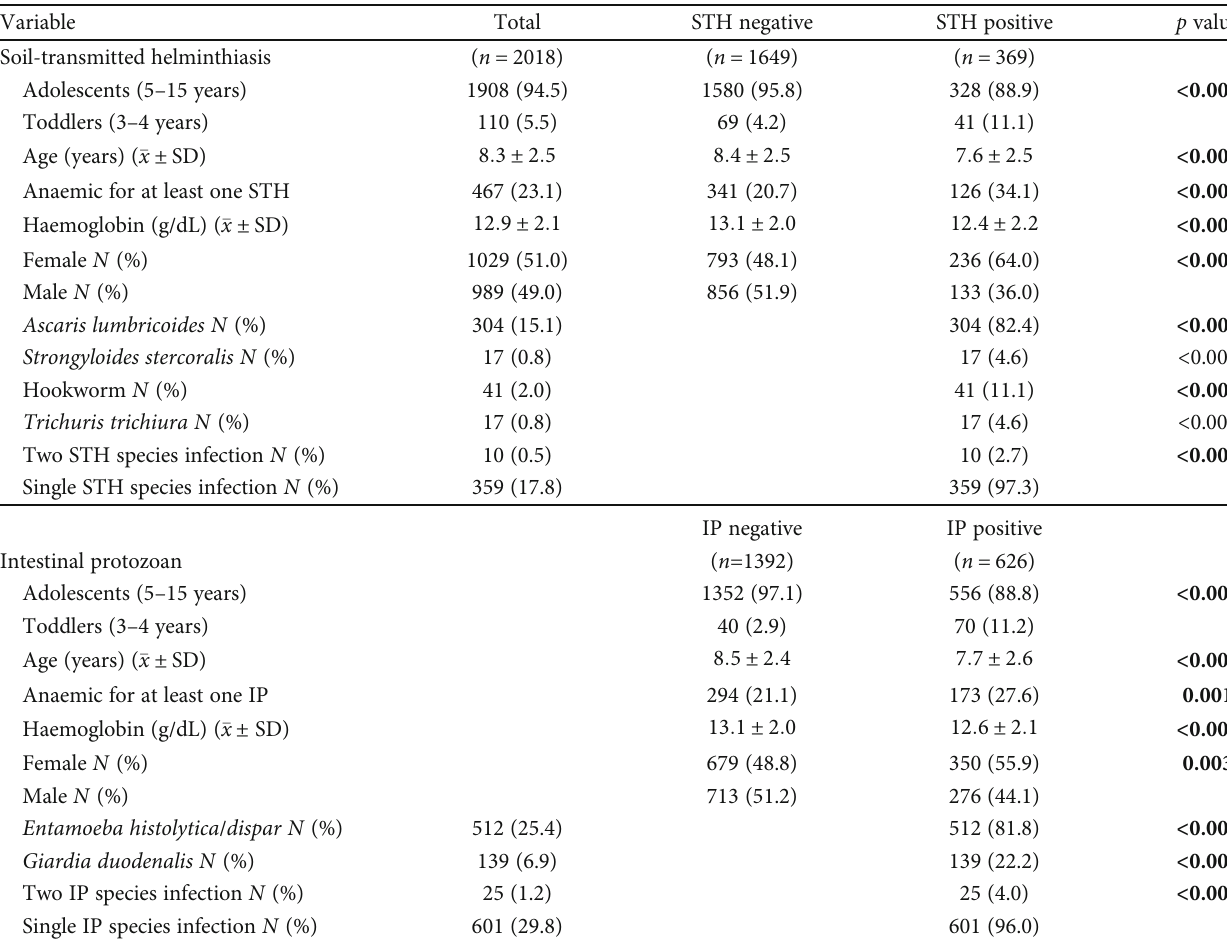
Table 1: Characteristics of the study population in association with STHs and intestinal protozoan